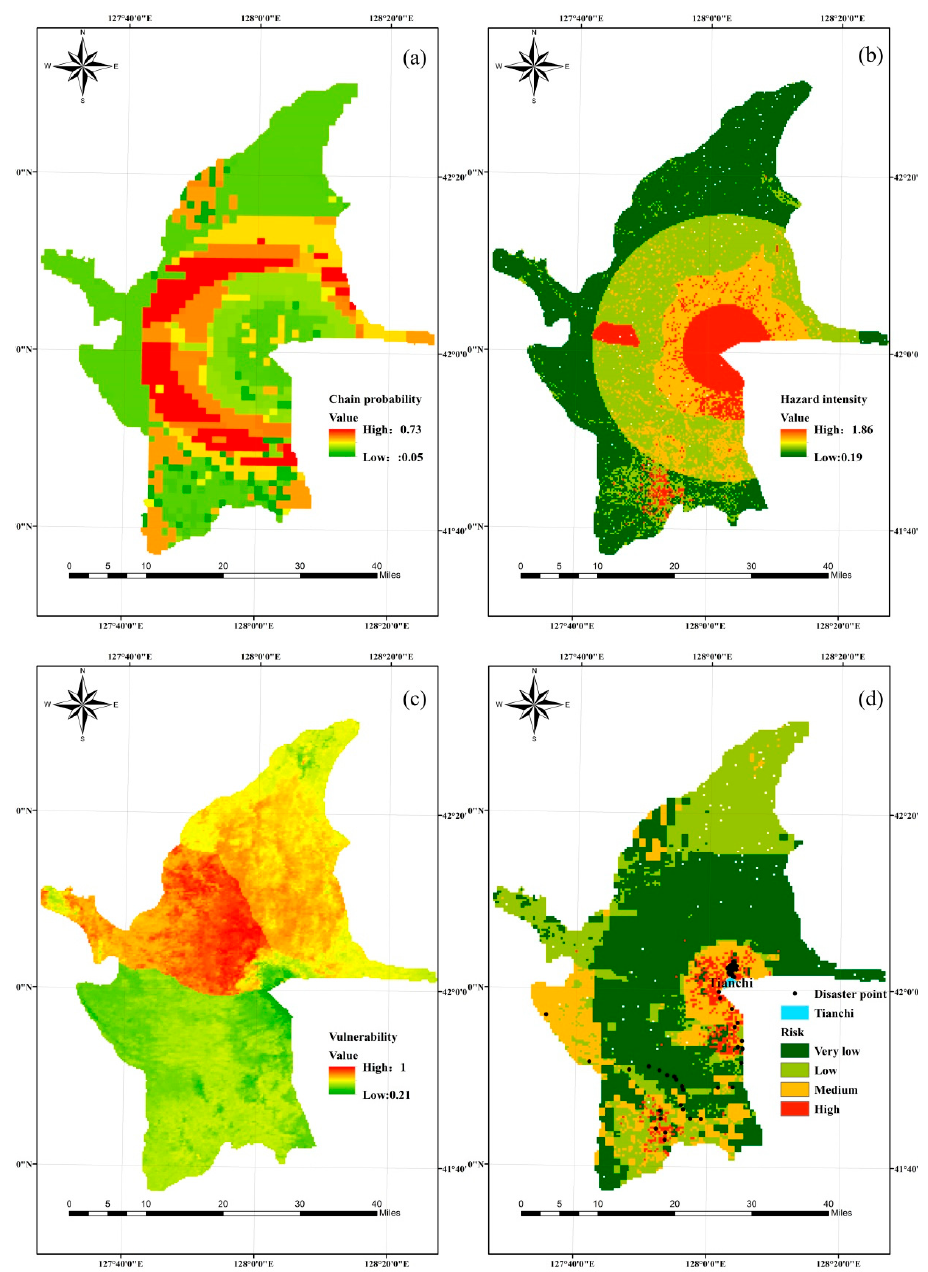
Figure 6. Earthquake–collapse–landslide disaster chain maps: ( a ) chain probability, ( b ) hazard intensity, ( c ) vulnerability, and ( d ) risk and disaster point locations.